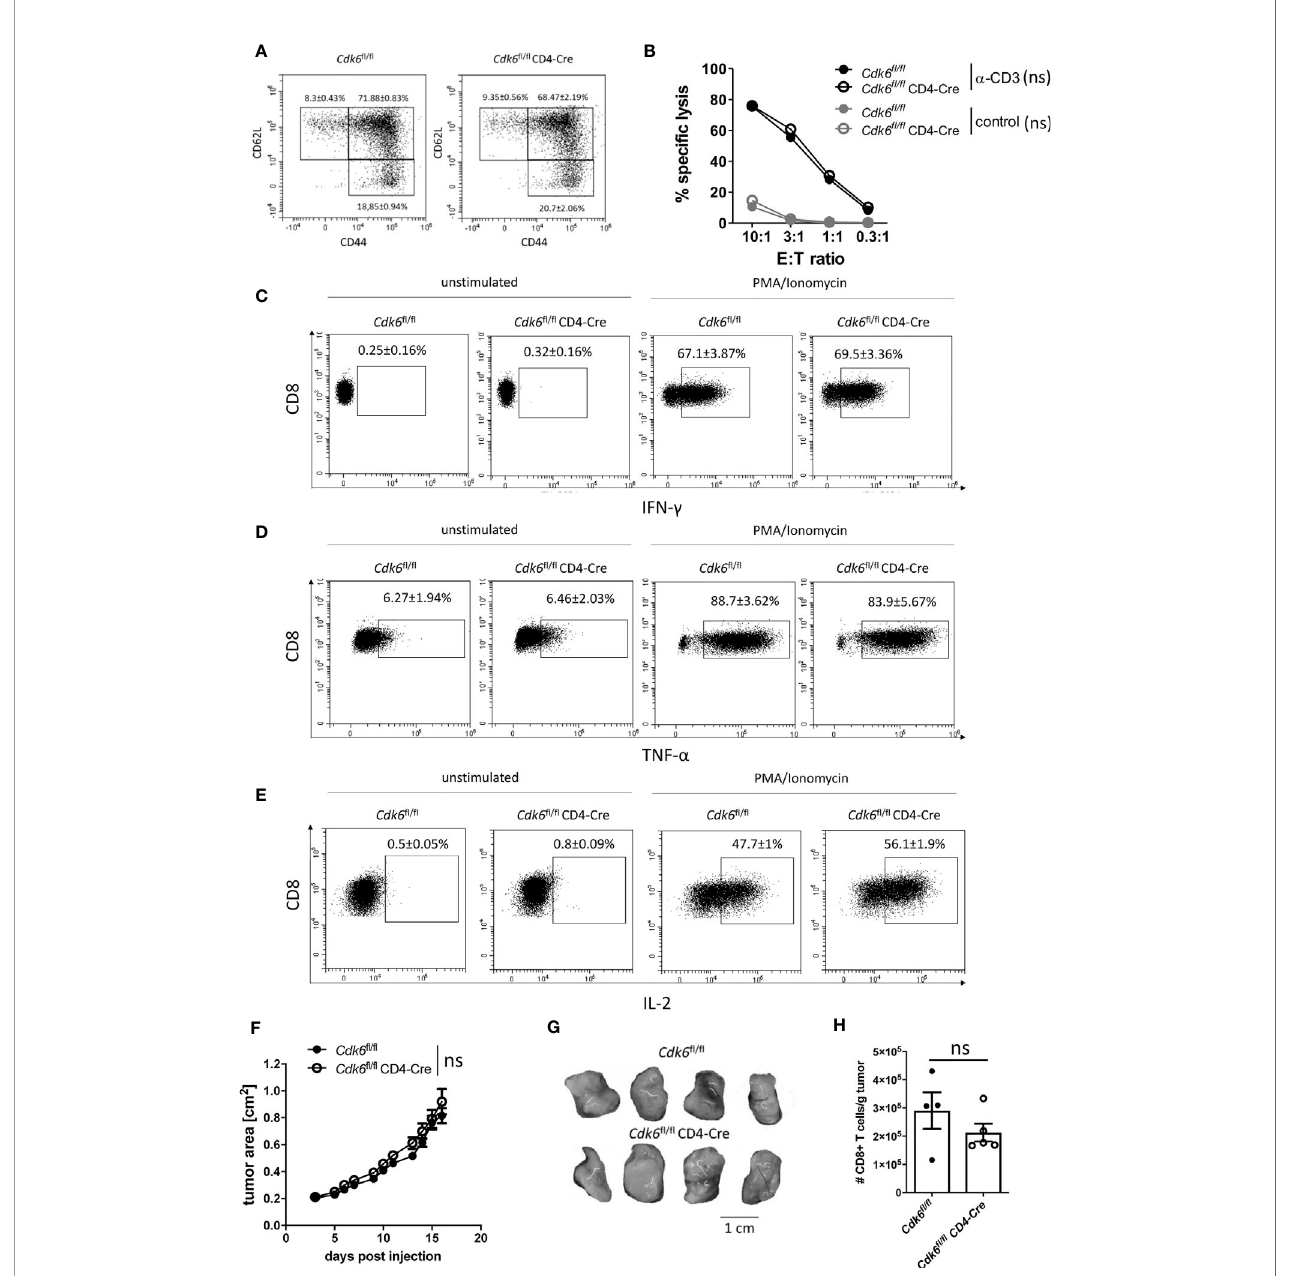
FIGURE 5 | T cell-intrinsic loss of CDK6 does not affect MC38 tumor growth in vivo . ( A – E) Splenic CD8+ T cells were isolated from Cdk6 fl / fl and Cdk6 fl / fl CD4-Cre mice, activated with a CD3/ a CD28 for 48h and cultured in the presence of IL-2. (A) Percentages of naïve (CD62L+CD44-), central memory (CD62L+CD44+) and effector memory (CD62L-CD44+) CD8+ T cells were analyzed after six days of culture by fl ow cytometry (n=4). Representative dot plots are shown. Figure S3A shows the corresponding bar graph with mean ± SEM values, pooled from two independent experiments. (B) Redirected cytotoxicity assay with the P815 target (T) cell line was performed with Cdk6 fl / fl and Cdk6 fl / fl CD4-Cre CD8+ T cells six days upon culture as effector (E) cells. Cells were incubated at different E:T ratios for 3h in the presence of a CD3 or with an FcR-blocking reagent (control). Speci fi c lysis of CFSE-labeled target cells was analyzed by fl ow cytometry (n=2). (C – E) Cultured Cdk6 fl / fl and Cdk6 fl / fl CD4-Cre CD8+ T cells were kept unstimulated or stimulated with PMA/Ionomycin for 4h and percentages of IFN- g (C) , TNF- a (D) and IL-2 (E) positive CD8+ T cells were analyzed by intracellular fl ow cytometric staining (n=4-5). Representative dot plots are shown. Figure S3E – G show the corresponding bar graphs with mean ± SEM values, pooled from two independent experiments. (F – H) Cdk6 fl / fl and Cdk6 fl / fl CD4-Cre mice were injected subcutaneously into both fl anks with 10 6 MC38 tumor cells. (F) Growth of the tumors was monitored by assessment of tumor area every 1-2 days. (G) Representative tumor pictures are shown. Figure S3H shows the bar graph with the corresponding tumor weights (n=4-5 mice per genotype (8-10 tumors per genotype)). (H) Absolute numbers (normalized to tumor weight) of tumor-in fi ltrating CD8+ T cells were analyzed by fl ow cytometry (n=4-5). (B, F) Symbols represent mean ± SEM from one experiment. (H) Bar graph represents mean ± SEM with symbols representing values from individual tumors from one experiment. ns, not signi fi